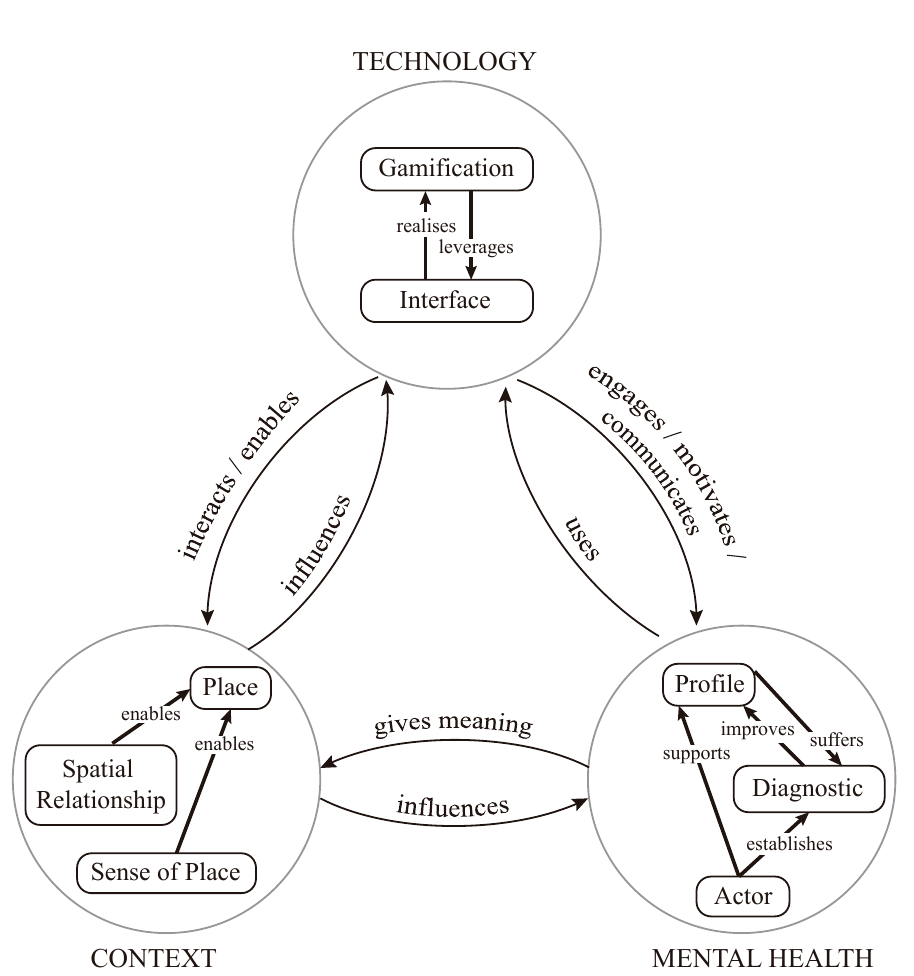
Figure 4. The design process of context-aware mobile apps is influenced by several interrelated dimensions that need to be considered as a